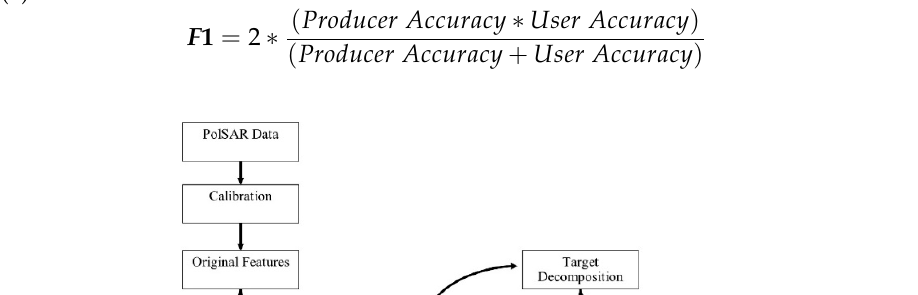
Table 3. Crop growth stages. Crop Growth Stages